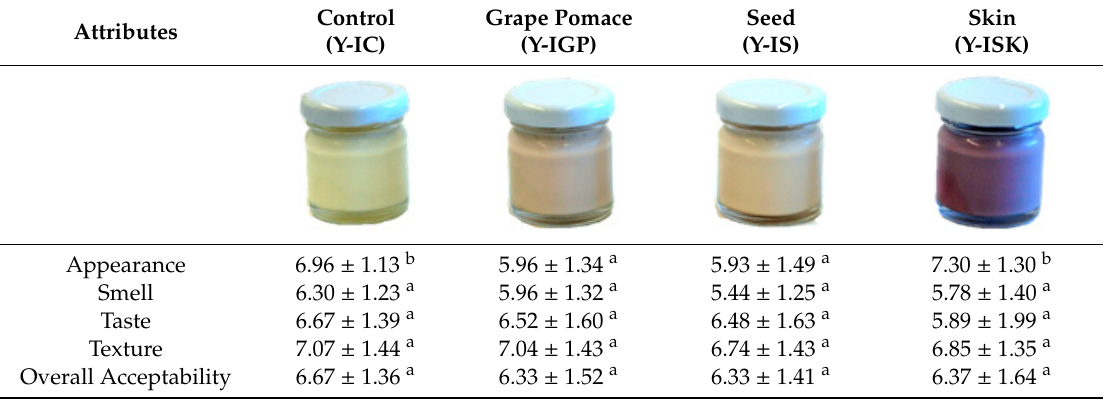
between yogurt samples ( p < 0.05).